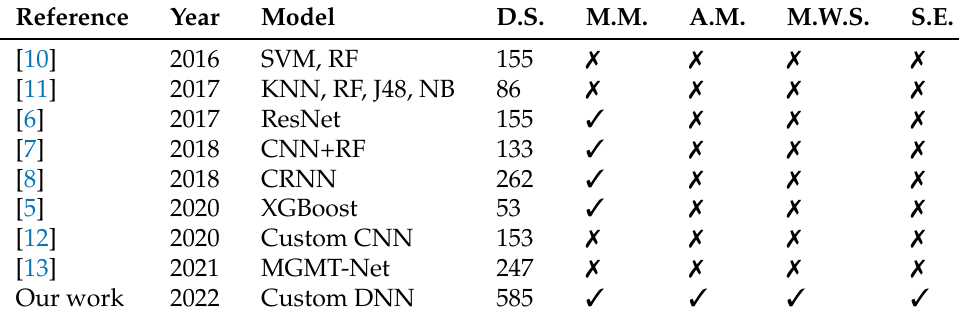
Table 1. A review of MRI-based learning models for the detection of MGMT methylation status. The table includes the following abbreviations: dataset size (D.S.), multi-modality (M.M.), attention mechanism (A.M.), modal-wise shortcut (M.W.S.), separable embedding (S.E.), support vector ma- chine (SVM), random forest (RF), k-nearest neighbor (KNN), naive Bayes (NB), convolutional neural network (CNN), and deep neural network